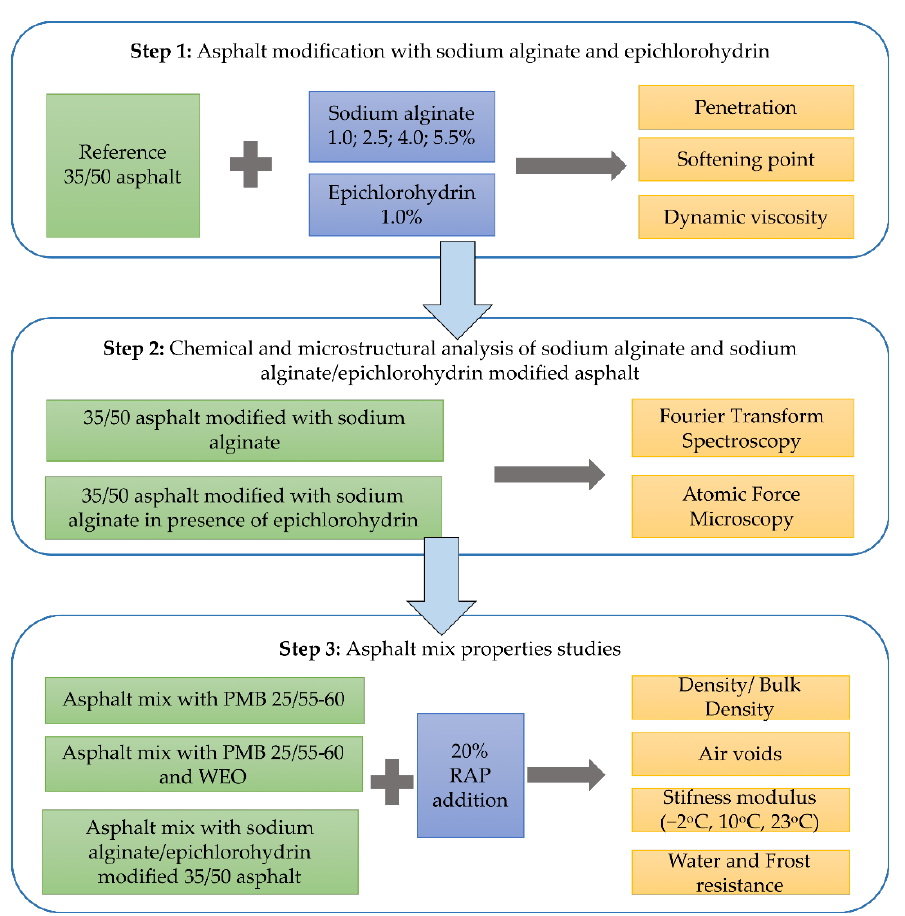
Figure 1. Research plan.